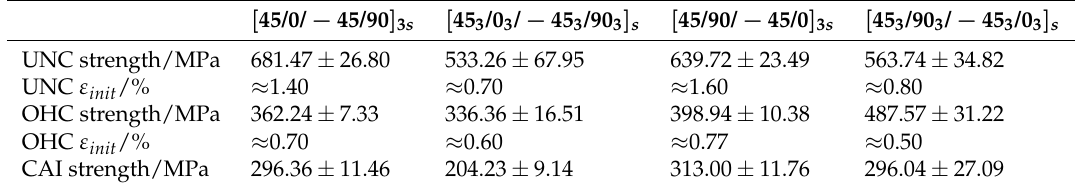
Figure 4. Representative OHC stress-strain curves and AE amplitude signals and cumulated energy over compressive strain for sublaminate ( a ) and ply-block ( b ) scaled specimens. Table 3. Test results from UNC, OHC and CAI tests. Strain at initiation of severe damage ε init is defined as the strain value at which first AE-signals with amplitudes >80 dB